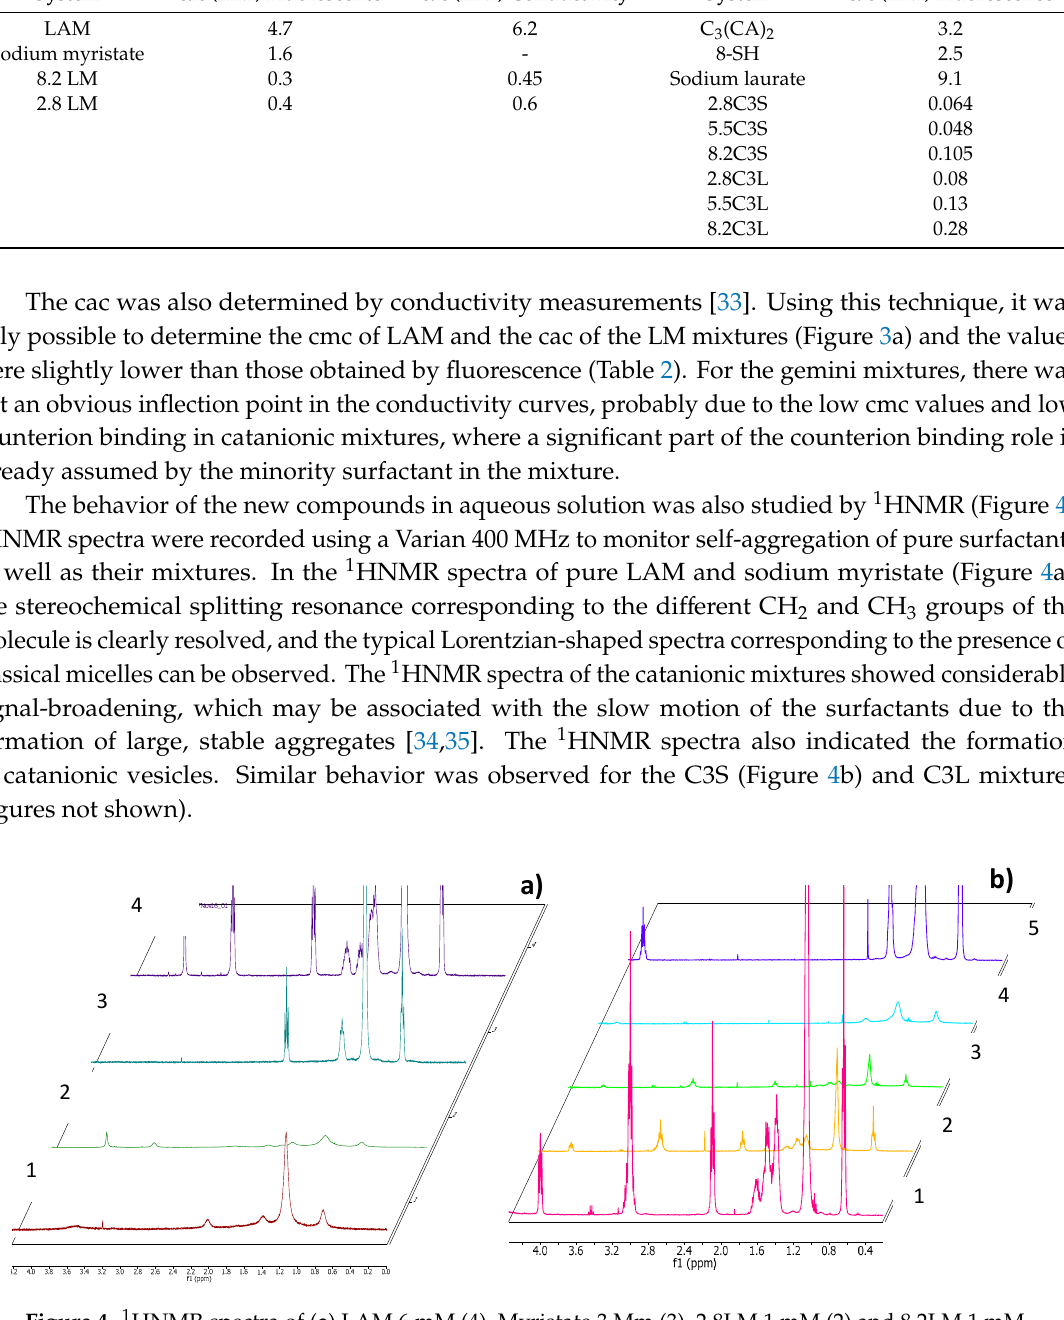
Figure 4. 1 HNMR spectra of ( a ) LAM 6 mM (4), Myristate 3 Mm (3), 2.8LM 1 mM (2) and 8.2LM 1 mM (1)( b ) C3S mixtures ( 1 C 3 (CA) 2 5 mM, 2 8.2 C3S 1 mM, 3 5.5 C3S 1 mM, 4 2.8 C3S 1 mM, 5 8-SH 5 mM).